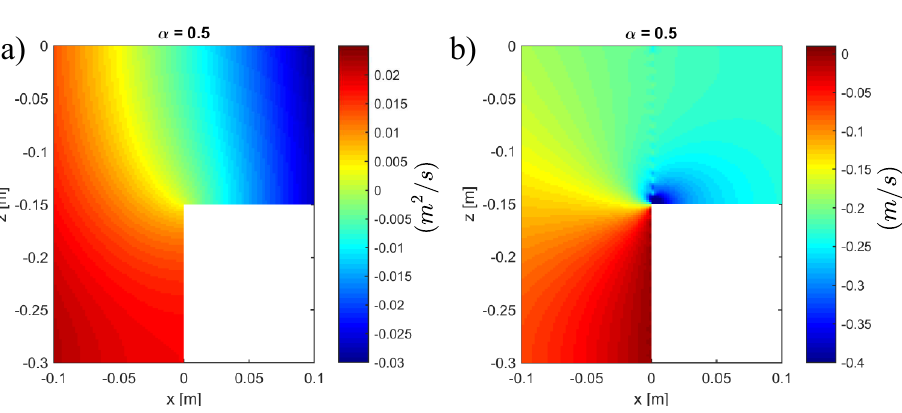
Figure 7. Convergent solution of the second-order problem for α = 0.5 (with truncation of forcing evanescent waves). ( a ) Velocity potential φ 2 at the second order near the step. ( b ) Horizontal velocity ∂ x φ 2 at the second order near the